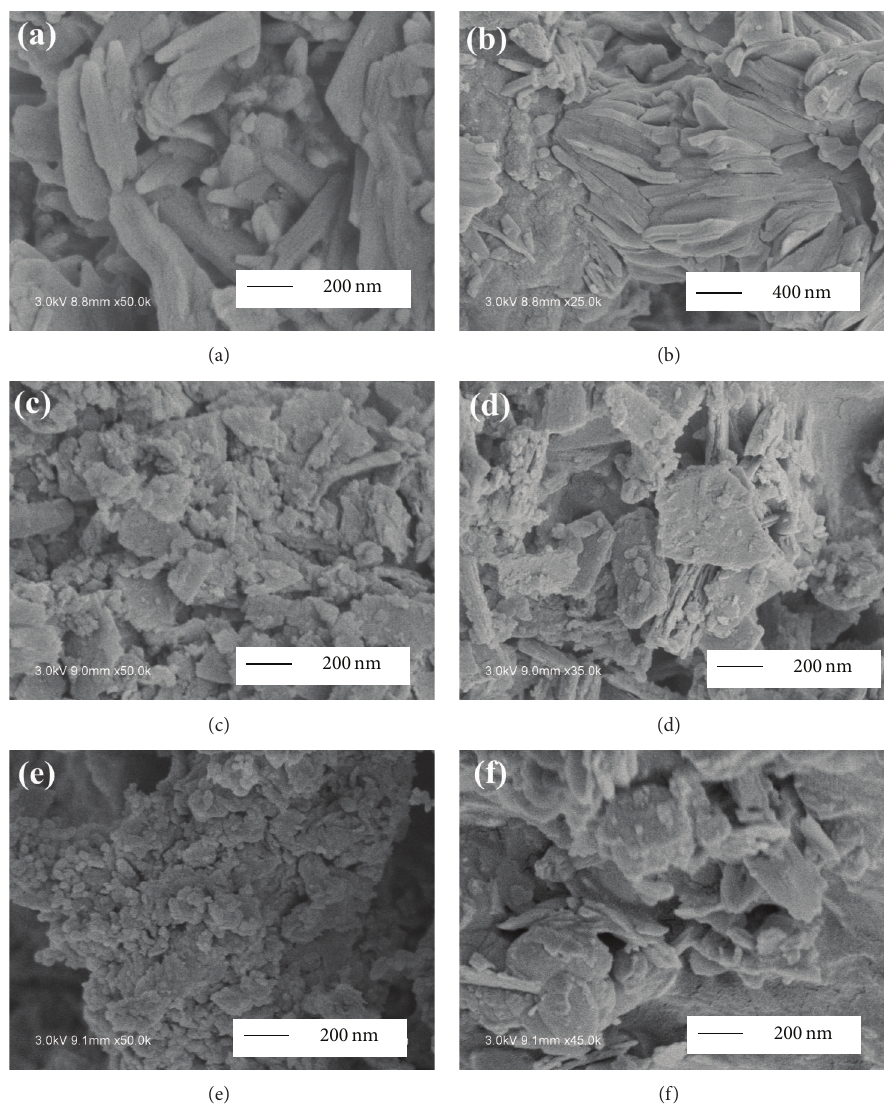
Figure 3: SEM images of (Ca 1−𝑥 , Ln 𝑥 )MoO 4 :0.05Eu 3+ (Ln = La and Gd) phosphors: (a) and (b) CaMoO 4 :0.05Eu 3+ , (c) (Ca 0.8 , La 0.2 )MoO 4 :0.05Eu 3+ , (d) (Ca 0.5 , La 05 )MoO 4 :0.05Eu 3+ , (e) (Ca 0.8 , Gd 0.2 )MoO 4 :0.05Eu 3+ , and (f) (Ca 0.5 , Gd 0.5 )MoO 4 :0.05Eu 3+